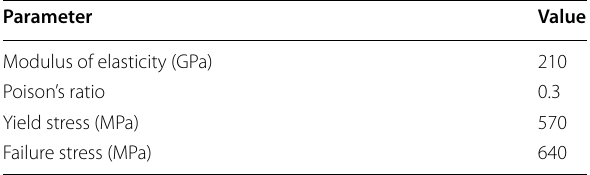
Table 8 Steel reinforcement